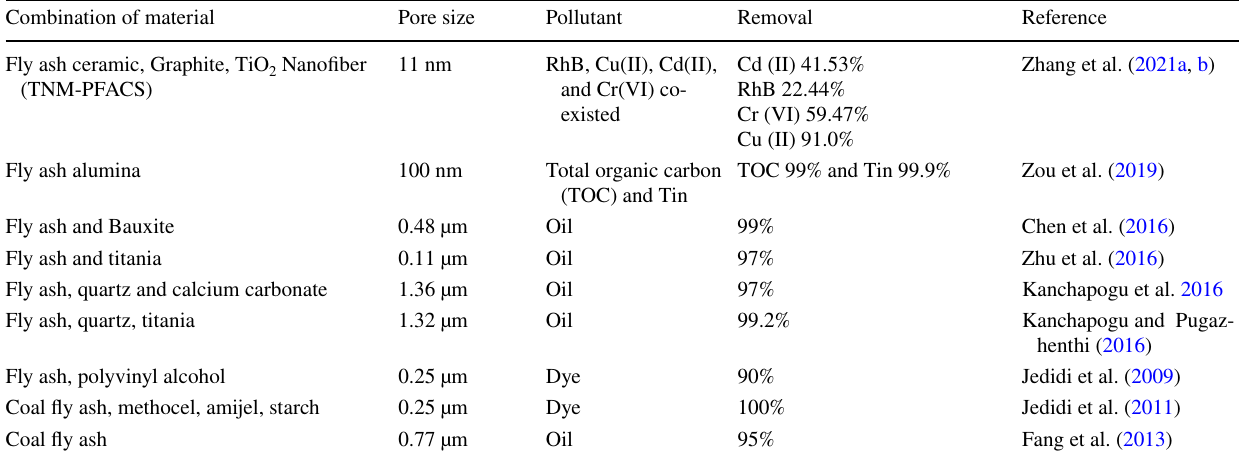
Fly ash, quartz and calcium carbonate